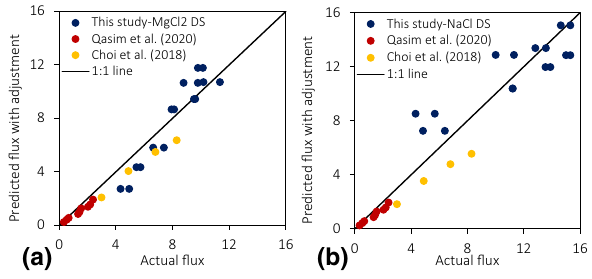
Fig. 9 Predicted water flux (L/m 2 ·h) with adjusted a Eq. (3) and b Eq.